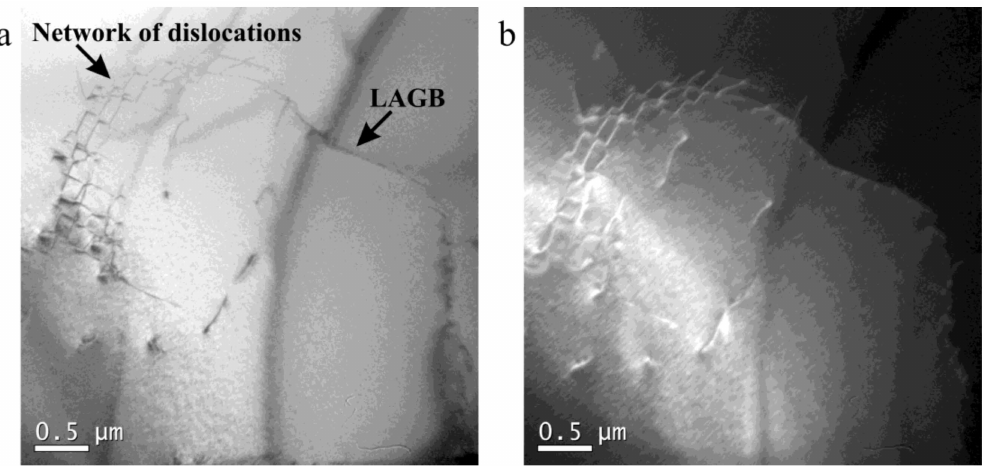
Figure 10. Transmission electron microscopy microstructure of 18Mn18Cr0.6N steel compressed to a strain of 0.4 at a cooling rate of 0.0125 Ks − 1 : ( a ) bright-field image; ( b ) corresponding dark-field image.